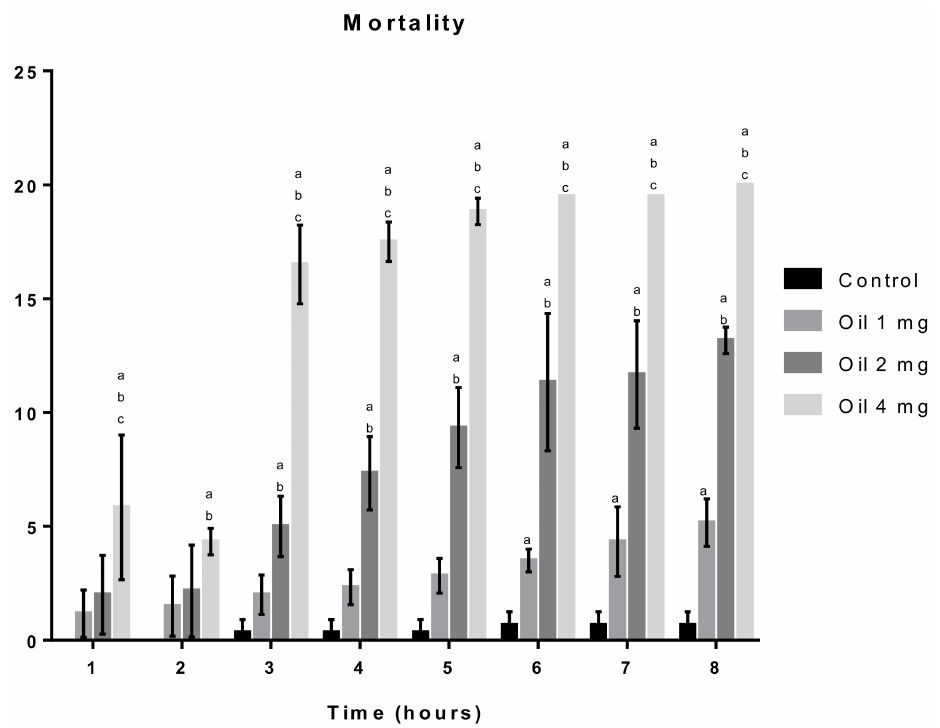
Figure 4. Effect of the D. ambrosioides leaf essential oil on D. melanogaster survival. Subtitles: Survival was analyzed at the indicated time points. Results are expressed as the Mean ± SD of the number of dead flies after each exposure time. a = p < 0.05 compared to the control, b = p < 0.05 compared to 1 mg/mL and c = p < 0.05 compared to 2